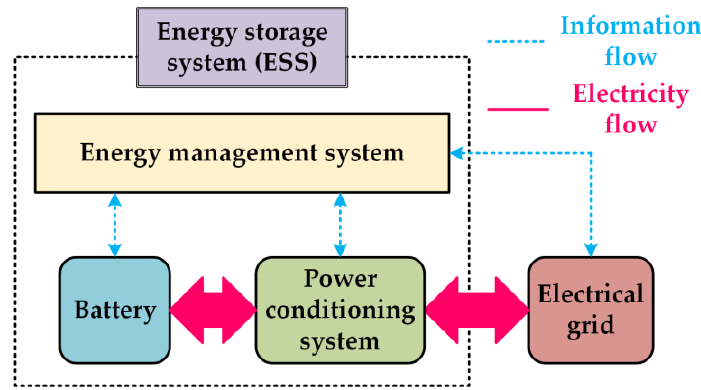
Figure 1. Basic configuration of a grid-connected battery energy storage system (BESS).